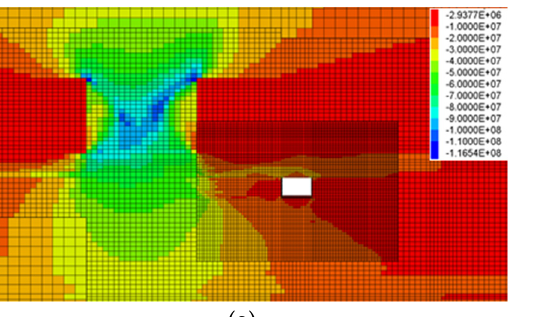
Figure 6. Principal stress distribution contour of the roadway’s surrounding rock when the roadway excavation along the roof. ( a ) σ 1 cloud. ( b ) σ 3 cloud.